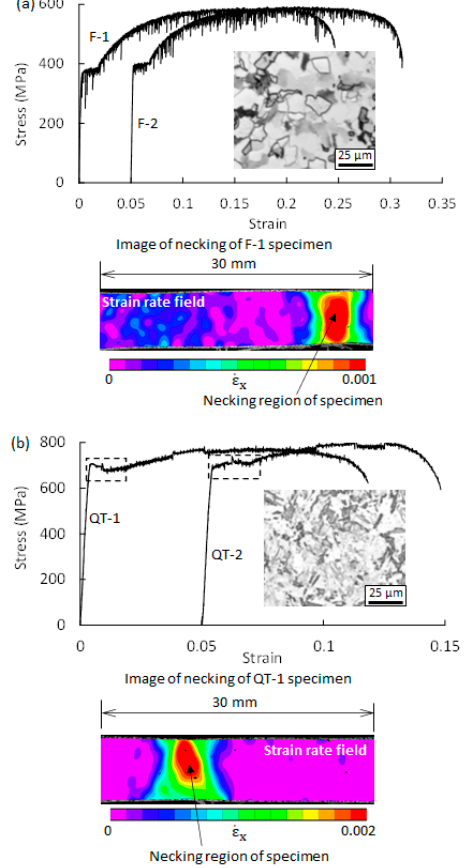
Figure 2. Macroscopic stress–strain curves of ( a ) ferrite/pearlite steel (F steel) and ( b ) tempered martensite steel (QT steel). Two tests were performed for each steel (F ‐ 1 and F ‐ 2 for F steel; QT ‐ 1 and QT ‐ 2 for QT steel).